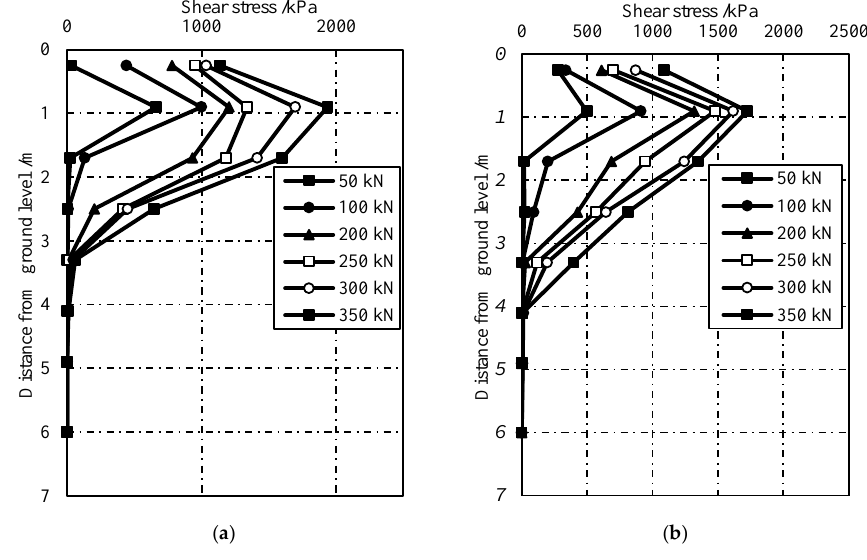
Figure 7. Shear stress versus depth: ( a ) GFRP-1 and ( b ) GFRP-2.